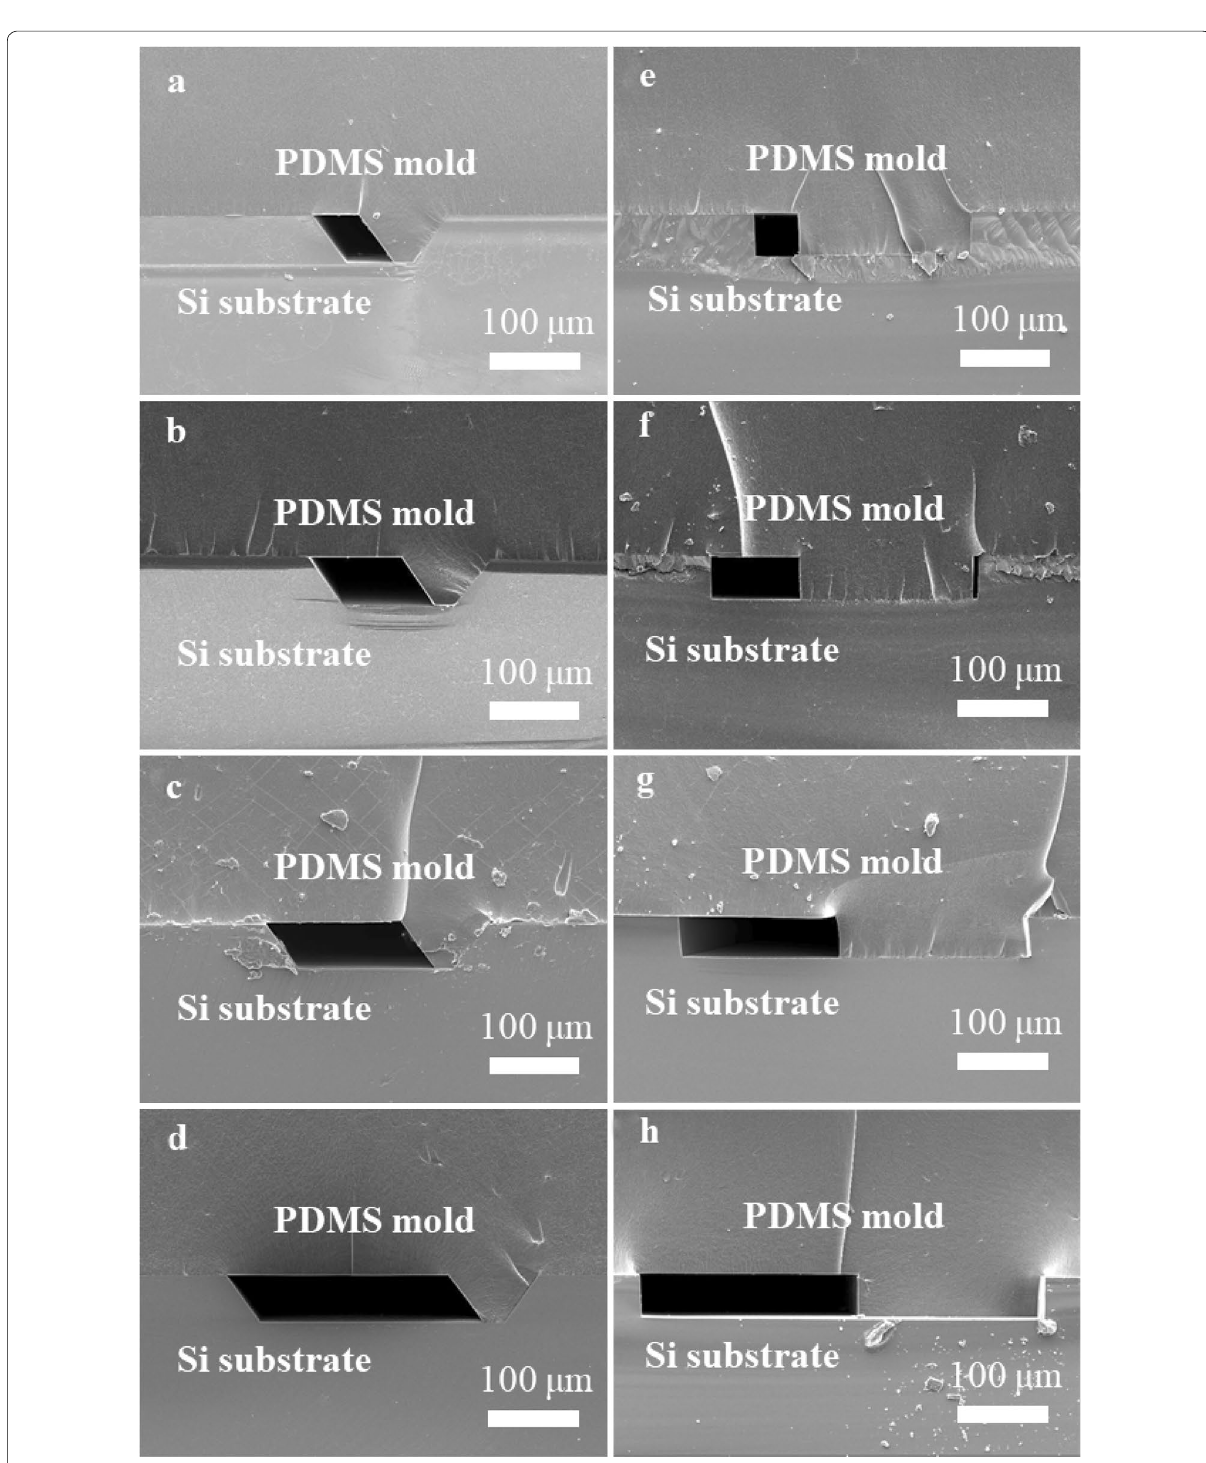
Fig. 3 SEM images of microchannels with parallelogram and rectangular cross sections a , b , c and d AR microchannels, e , f , g and h AR 1, 2, 3, 5 rectangular =